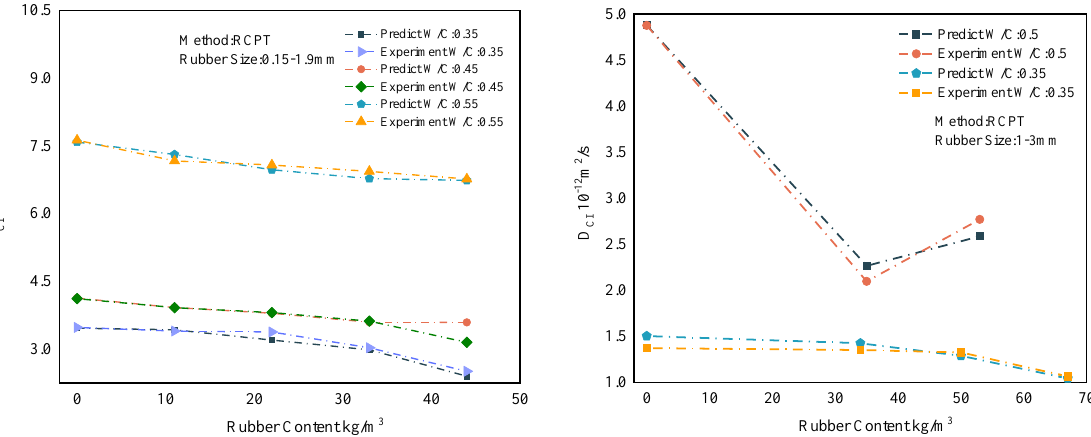
Figure 17. Prediction results of the MWOA-ELM model for the literature [54] ( Left ) and [55] ( Right ).